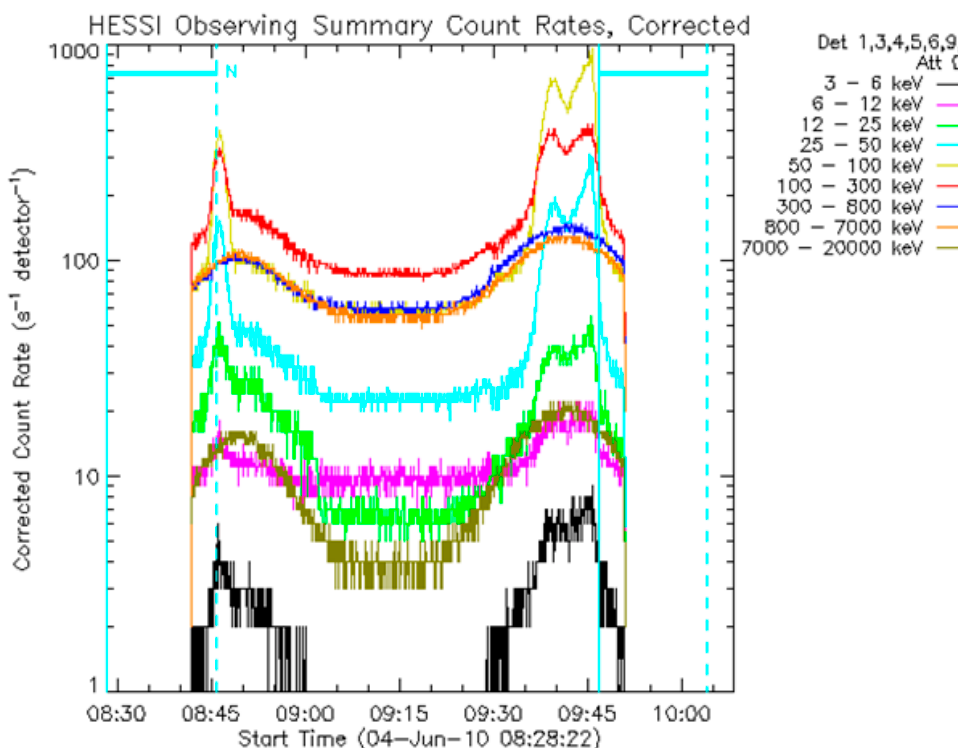
Figure 2. An example of both sudden and gradual solar flares was detected in RHESSI on 4 June 2010. The figure was extracted from (https://sprg.ssl.berkeley.edu/~tohban/browser/, accessed on 20 July 2022). Our two cases of flares appear more clearly in the RHESSI solar flares that are shown in the black, burble, and green lines.